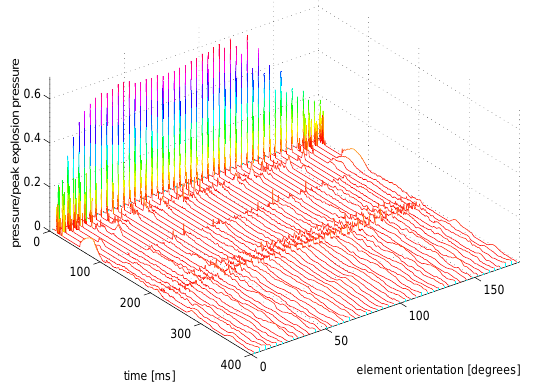
Fig. 7. Hull pressures as a function of time and position angle φ .